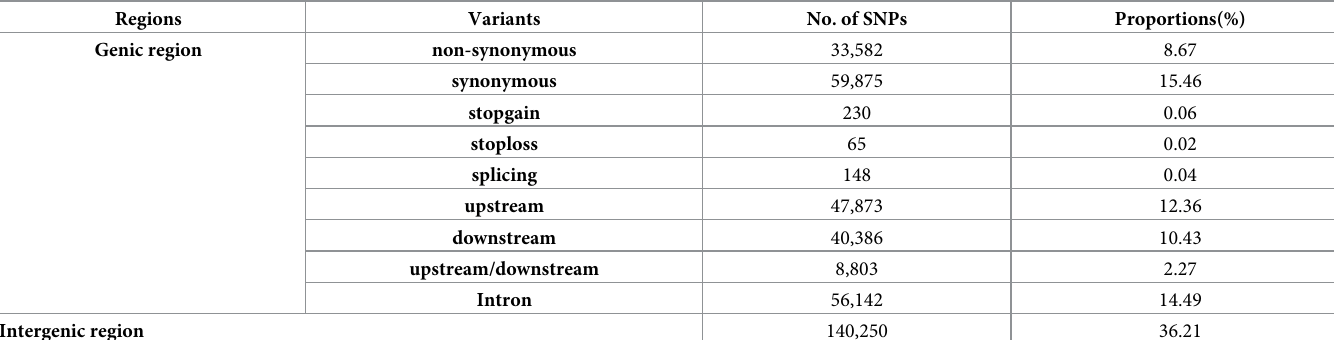
Table 2. Classification of KASP-SNPs resource in genic and intergenic regions. Regions